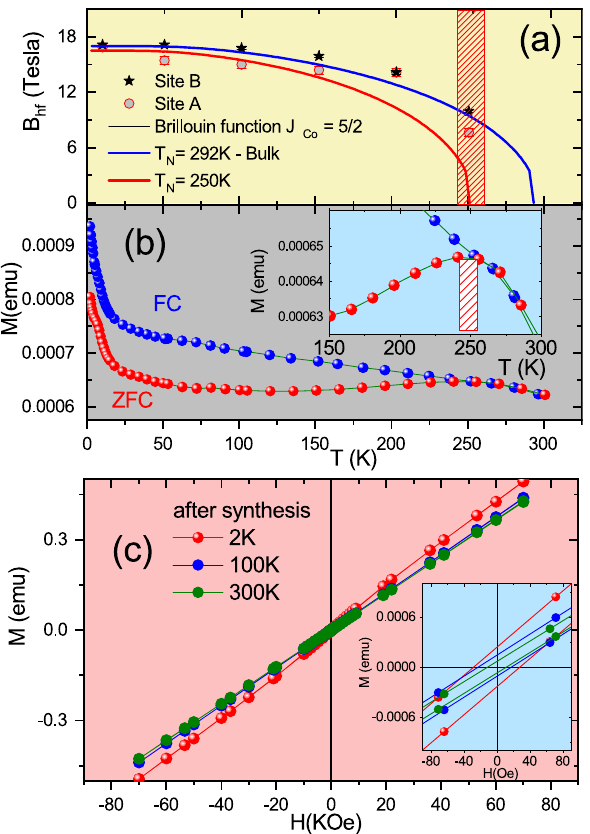
111 Cd for sample S2 up to room